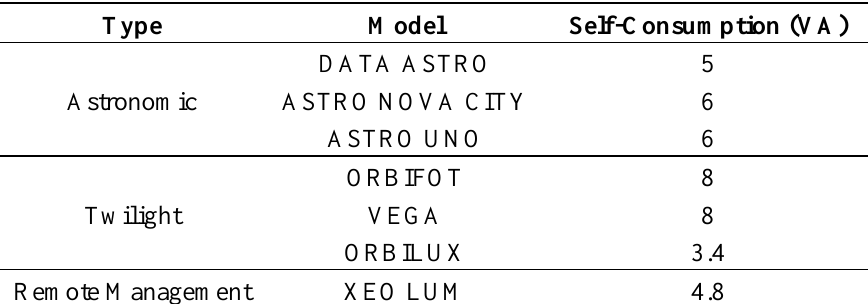
Table 10. Power consumption of street lighting control